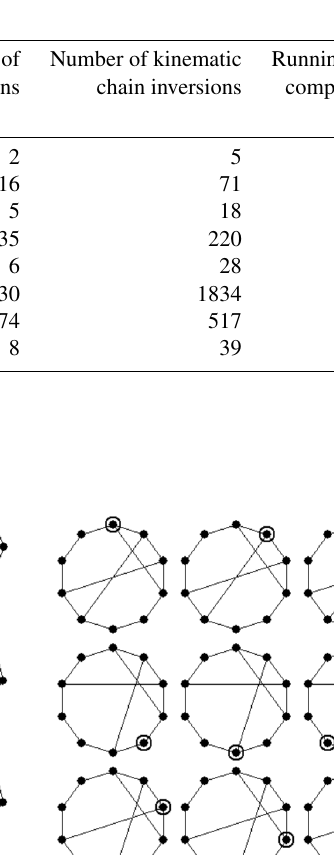
Table 1. Synthesis results of kinematic chain inversions.